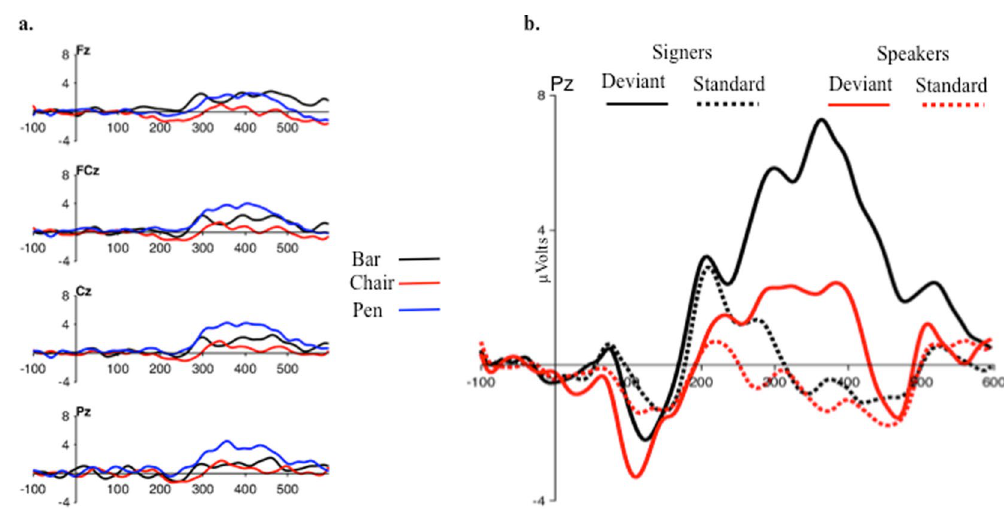
Figure 5. Panel (a) Waveforms generated by subtracting speakers’ deviancy effects from signers’ deviancy effects. Deviancy effects indicate larger positive amplitudes for deviants relative to standards. Waveforms correspond to differences obtained with pen, chair, and bar in four central electrodes (Fz, FCz, Cz, and Pz). In the 250–550 ms interval, a larger deviancy effect appeared for signers with pen, especially in posterior electrodes (Pz). Panel (b) ERPs elicited by the standard and deviant pen in the Pz electrode (signers: black lines; speakers: red lines). Only the deviant pen elicited larger amplitudes in signers than in